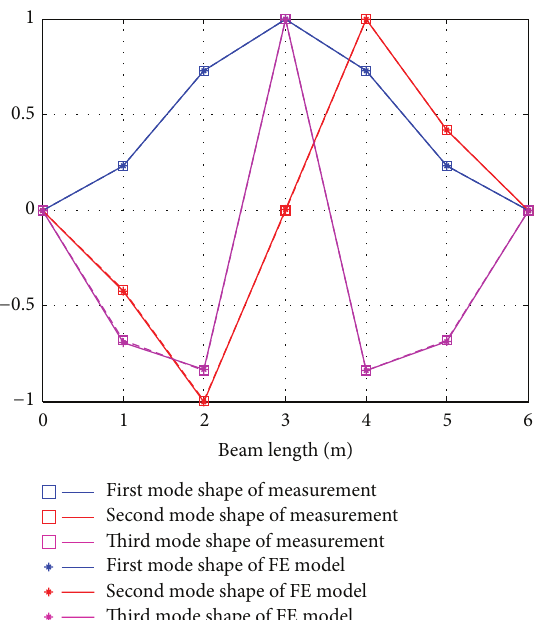
Figure 6: Comparison of mode shapes from measurements and updated model for multiple damage